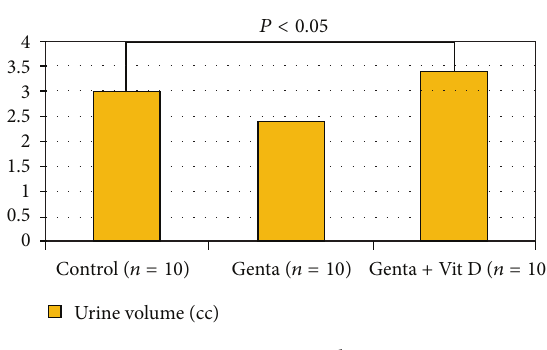
Figure 2: Urine Volumes.